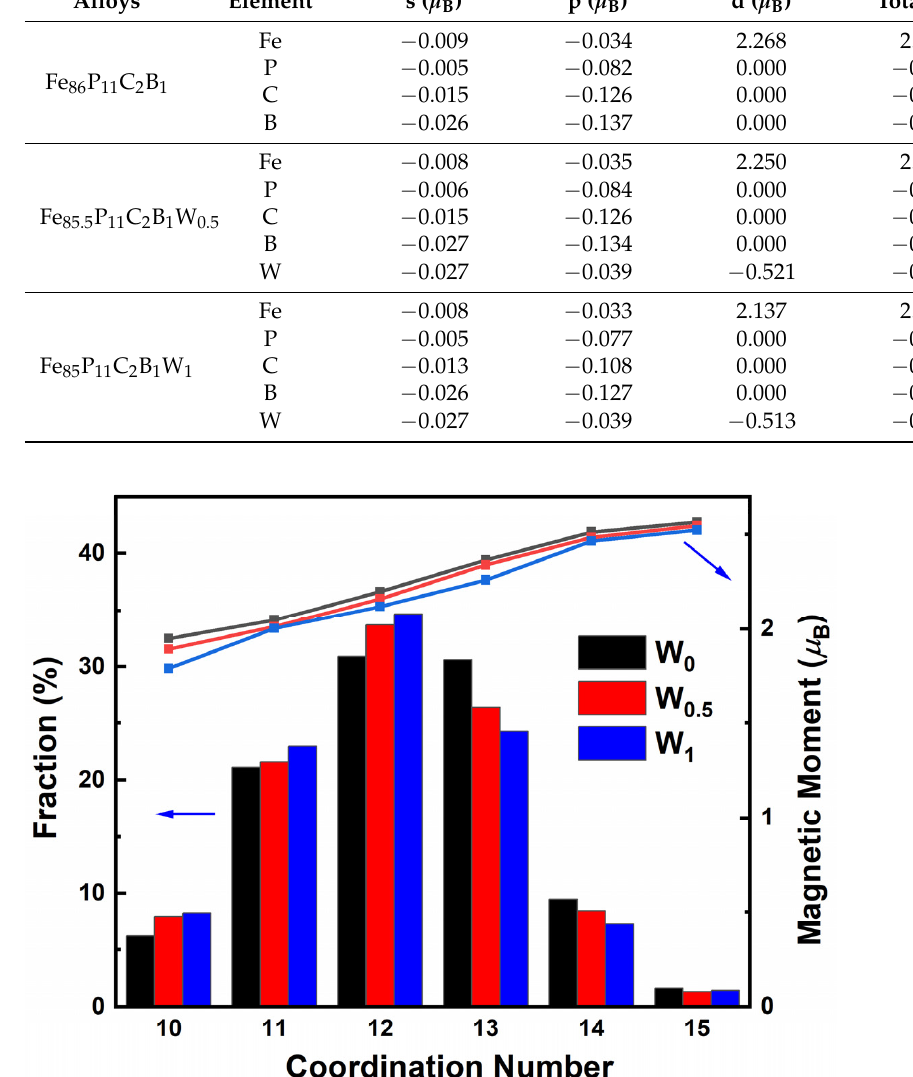
Figure 7. Fe magnetic moment distribution with corresponding coordination number in the Fe 86 − x P 11 C 2 B 1 W x (x = 0, 0.5, and 1) amorphous alloys. The tunable electronic performances of Fe 86 − x P 11 C 2 B 1 W x (x = 0, 0.5 and 1)